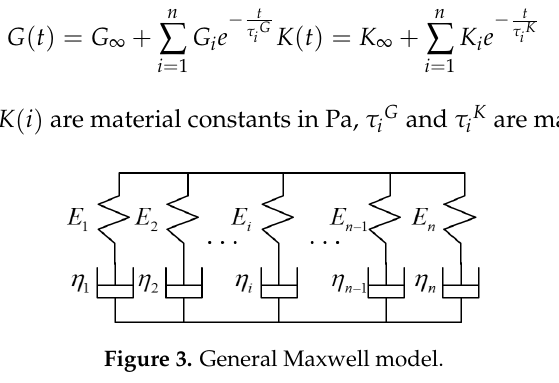
Figure 4. Pavement structure.